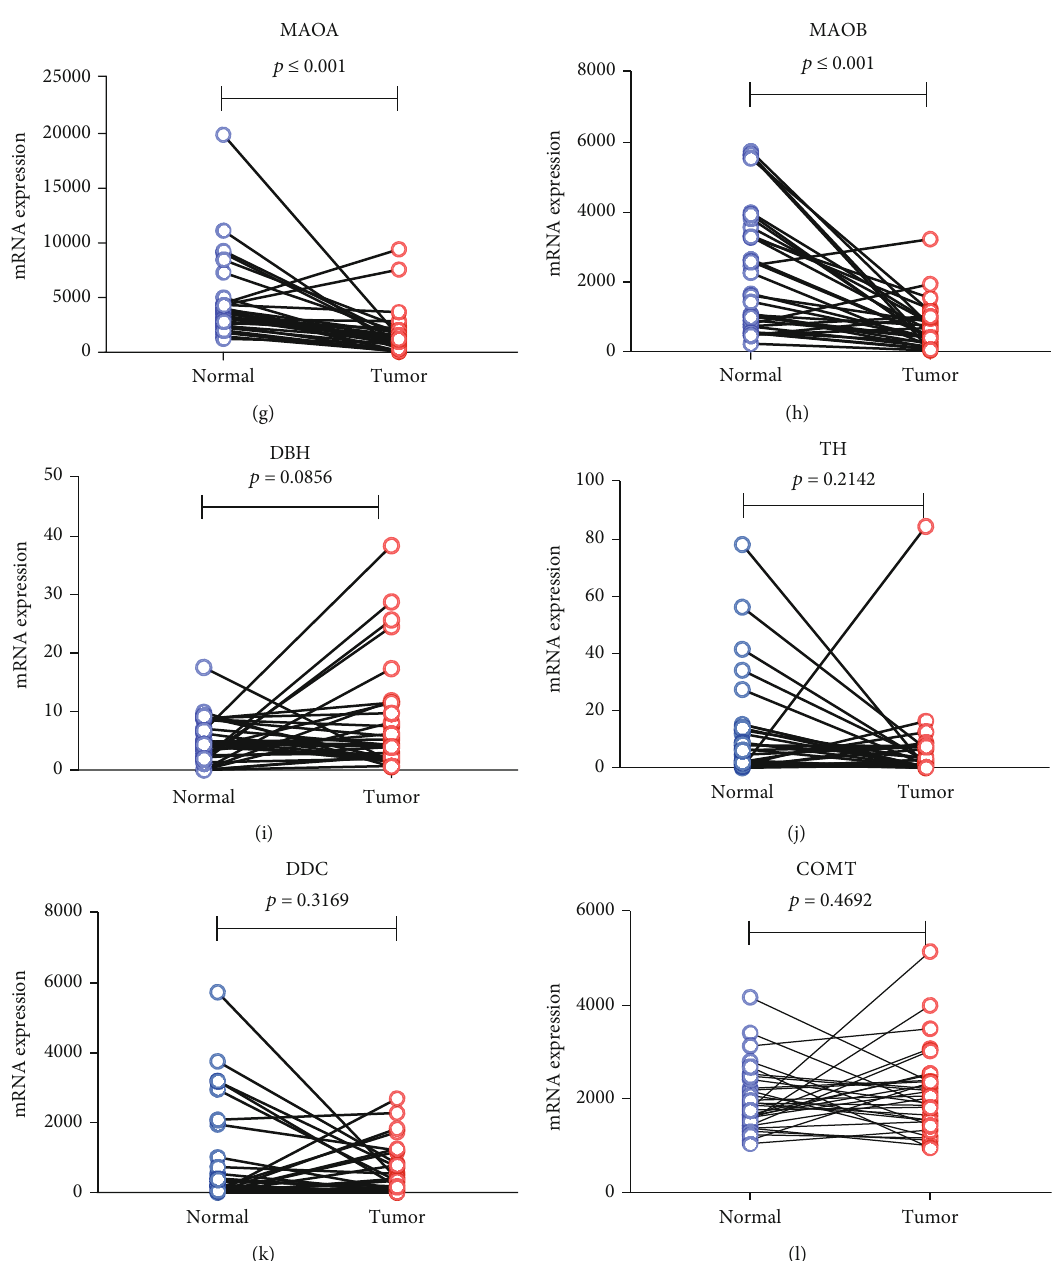
Figure 2: The mRNA levels of the monoamine neurotransmitter-degrading enzymes MAOA and MAOB are low in gastric cancer tissue, while those of the other synthetase and degrading enzymes TH, DDC, DBH, and COMT are not signi fi cantly di ff